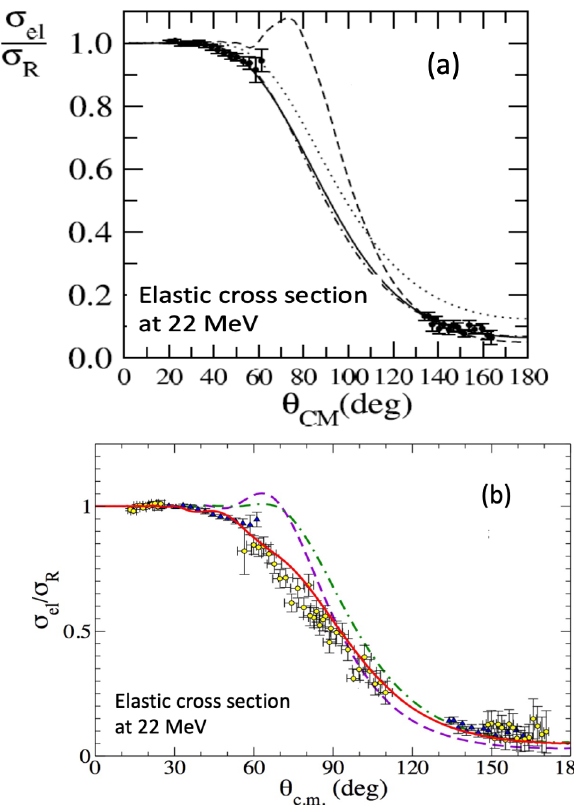
Fig. 1. Elastic scattering of the system 6 He + 208 Pb at 22 MeV from ref [3] (up) and ref. [4] (down). The various curves are scattering calculations; see text for